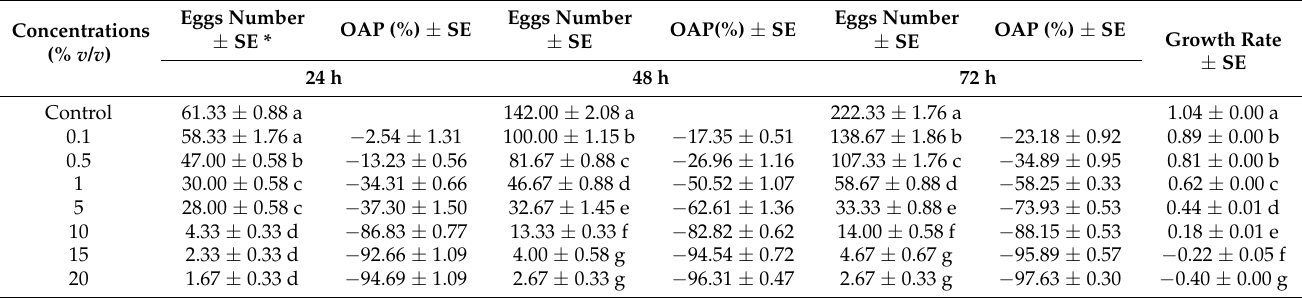
* Mean values and ± standard errors (SE) are presented. Different letters indicate significant differences ( p < 0.05; ANOVA and Tukey’s HSD test). OAP, percentage of oviposition